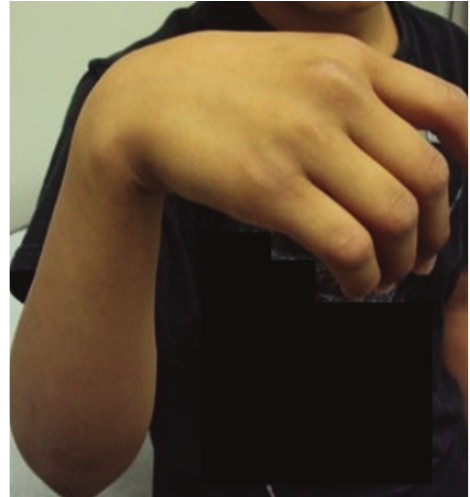
Figure 1: Clinical photograph showing a complete right wrist drop at presentation.